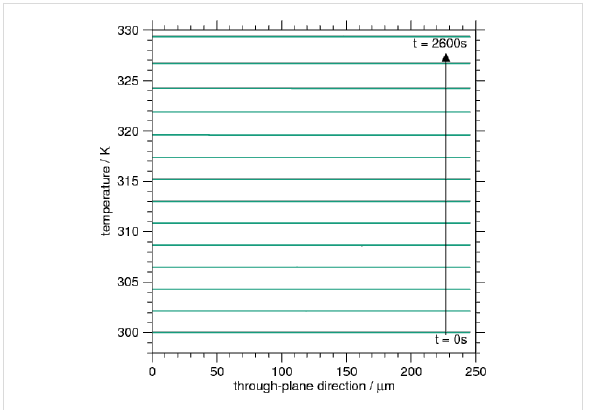
Figure 8: Spatial variation of temperature in through-plane direction for the microscopic ellipsoid